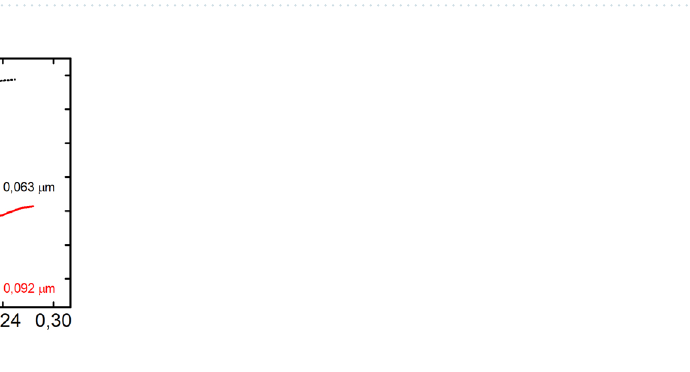
Figure 8. Cathodoluminescence intensity for one dislocation for QWs emitting at λ = 395 nm and λ = 466